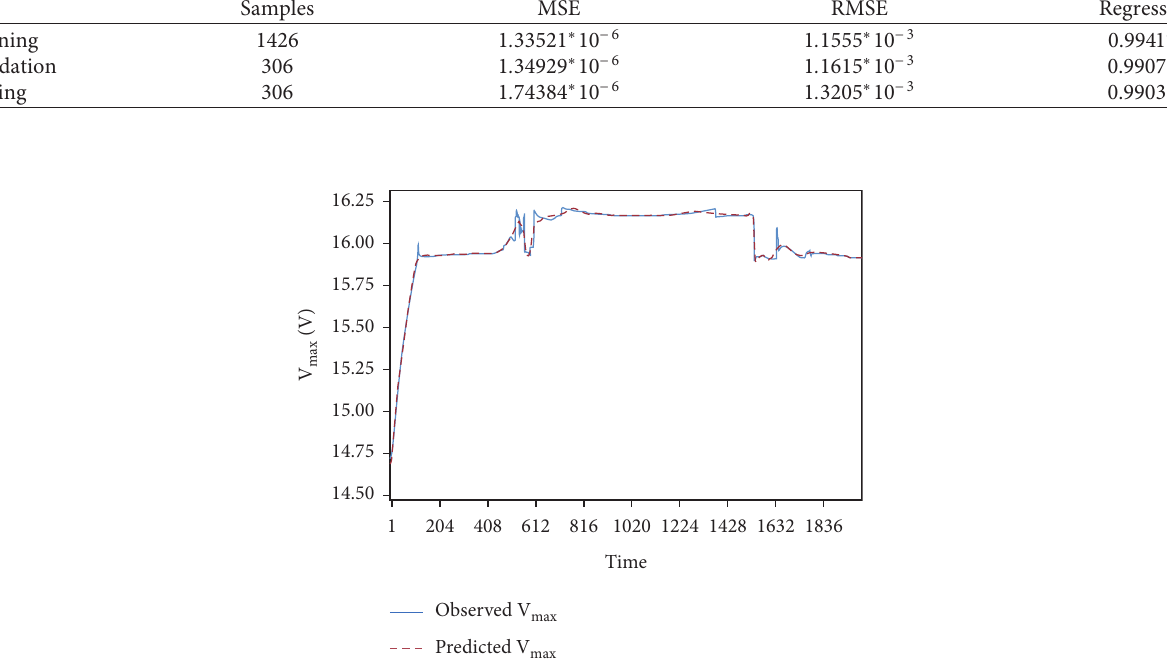
of measured and predicted V max